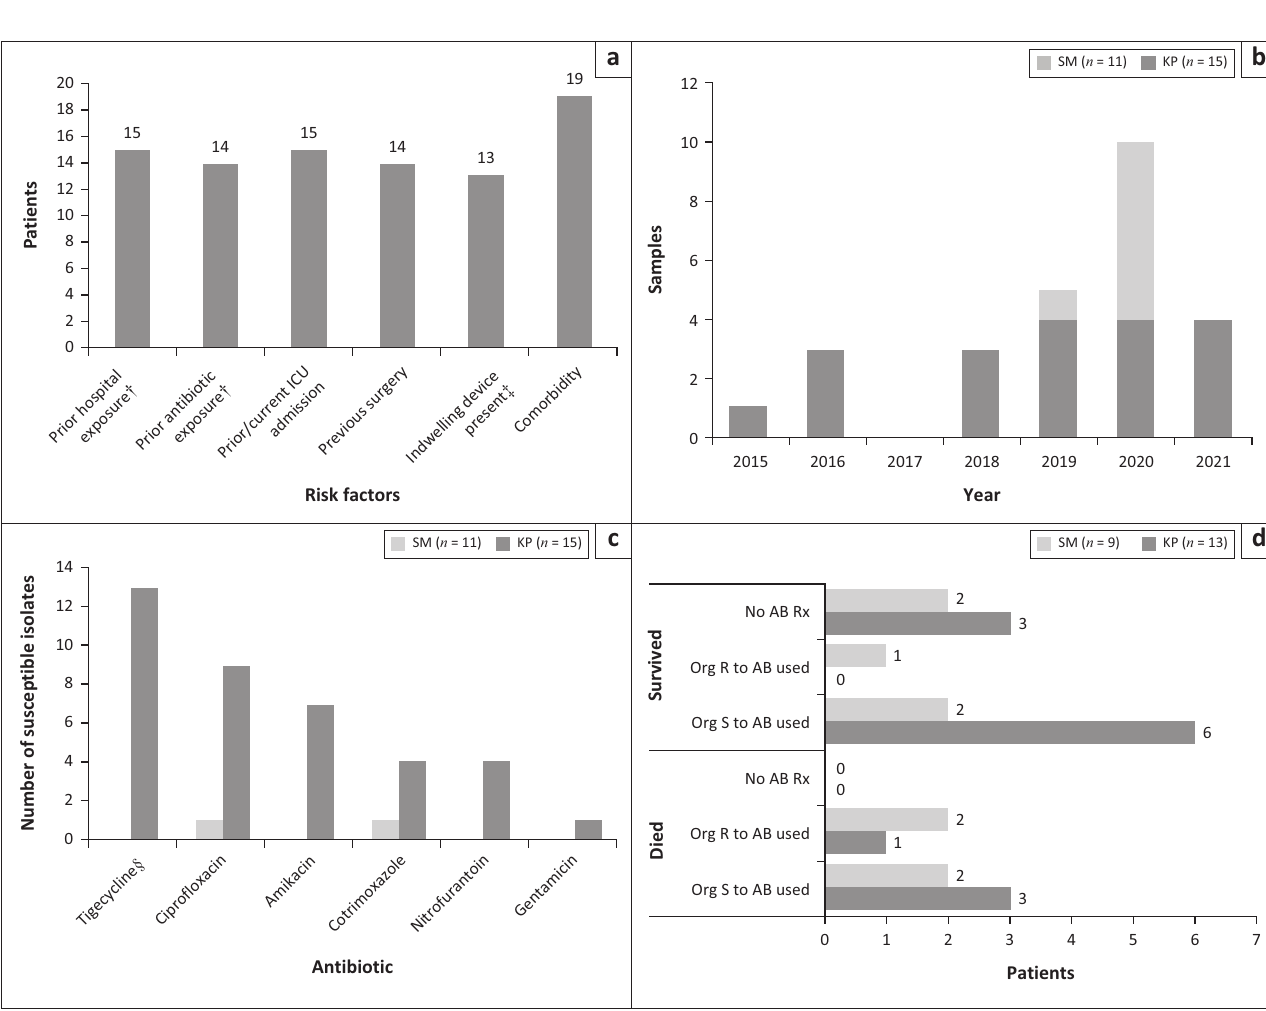
FIGURE 1: Graphic representation of (a) risk factors for infection with NDM-producing Enterobacterales, (b) the number of NDM-producing Enterobacterales identified during the study period by organism, (c) antibiogram of NDM-producing Enterobacterales (number of susceptible isolates to currently available antibiotics), and (d) outcome stratified by organism, antibiotic susceptibility and antibiotic treatment